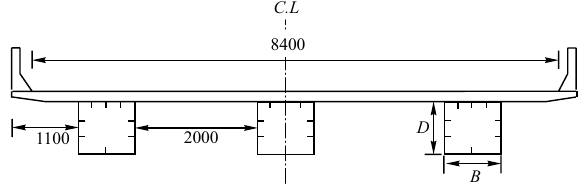
Fig. 5. Typical cross-section of a box girder bridge (dimensions in mm)